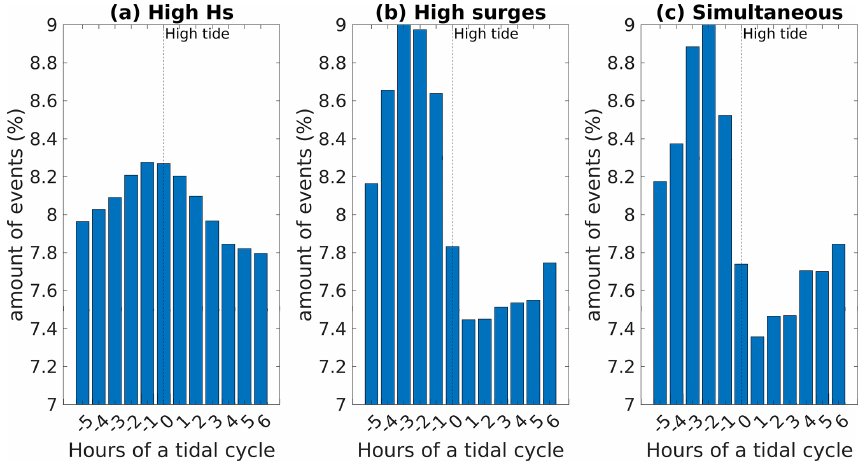
Figure 6. Percentage of the high ( > 90th percentile) H s (a) and surges (b) occurring as a function of tidal cycle stage during winter 2013/4 storm events. Percentage of simultaneous events shows when both H s and surges are within the upper 90th percentile concurrently (c) .